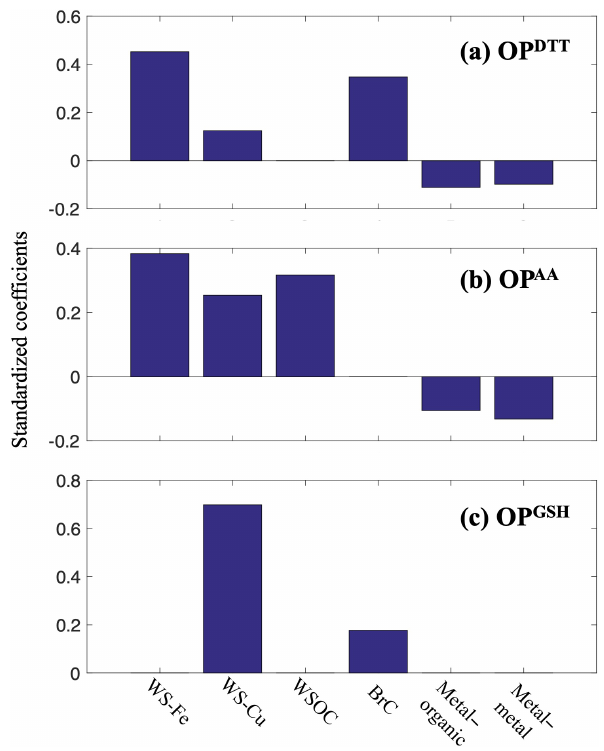
Figure 4. Standardized regression coefficients for different OP mea- sures with selected PM